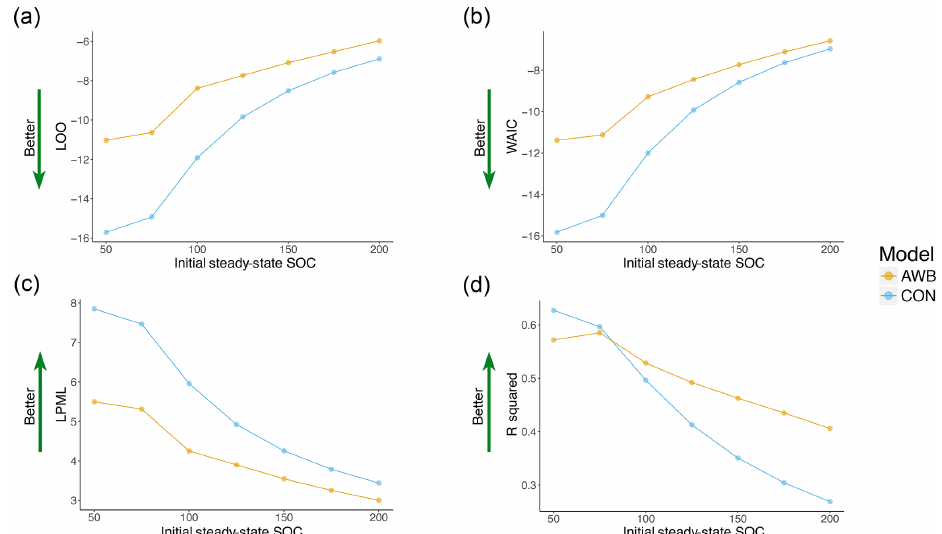
Figure 5. Goodness-of-fit metrics plotted against initial steady-state SOC for AWB and CON models for (a) LOO, (b) WAIC cross validation, (c) LPML, and (d) R 2 values. Preperturbation steady-state MIC, DOC, and ENZ (for AWB) are held constant as preperturbation SOC is